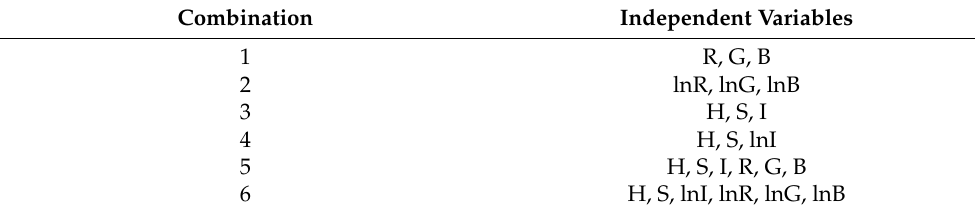
Table 2. Combinations of independent